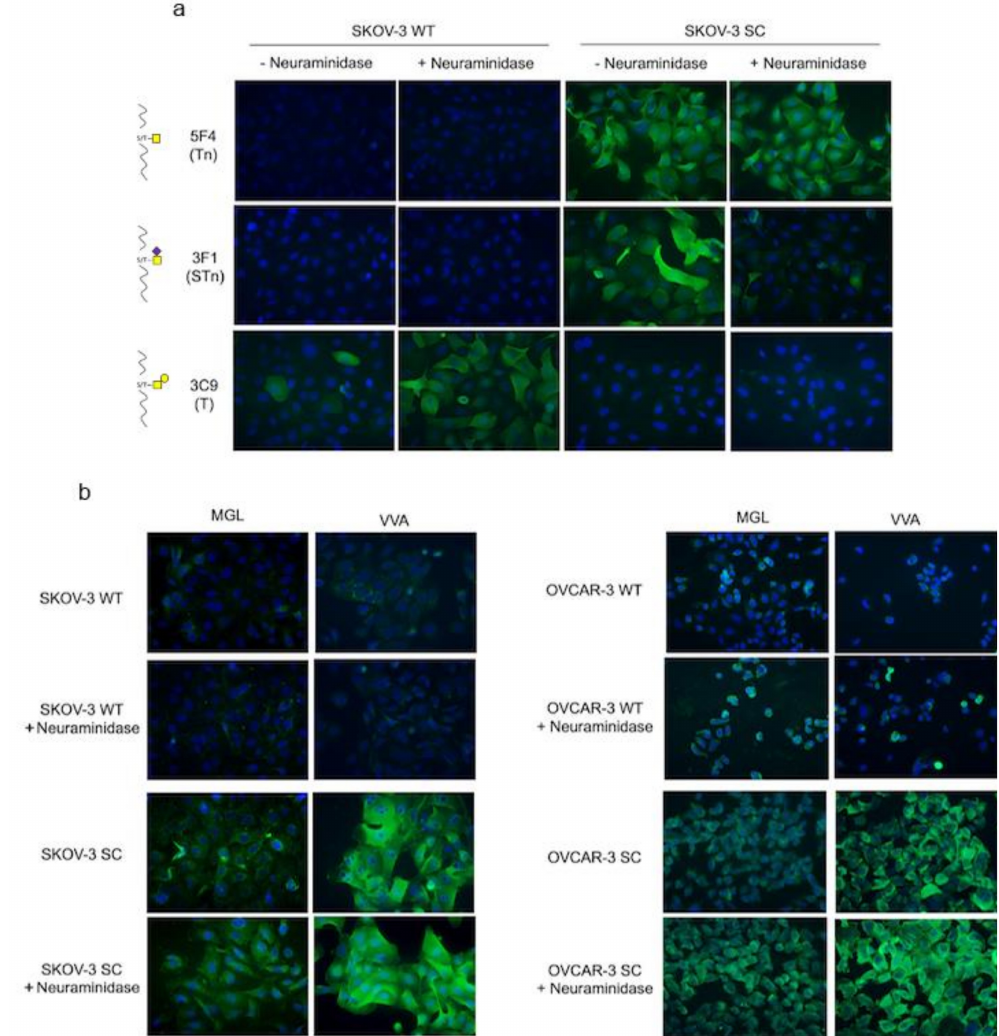
Figure 2. Glycoprofiling and lectin binding of SKOV-3 and OVCAR-3 ovarian cancer cell lines. ( a ) Immunofluorescence of wild-type (WT) and SimpleCell (SC) modified SKOV-3 cell line with and without neuraminidase treatment stained with anti-Tn mAb 5F4, anti-STn, mAb 3F1, and anti-T mAb 3C9. ( b ) Fluorescence microscopy of WT and SC SKOV-3 and OVCAR-3 with and without neuraminidase treatment, stained with rhMGL or VVA lectin (magnification 20 × ). 3.3. MGL Preferentially Recognizes Ovarian Cancer Associated Glycoproteins Carrying Multiple